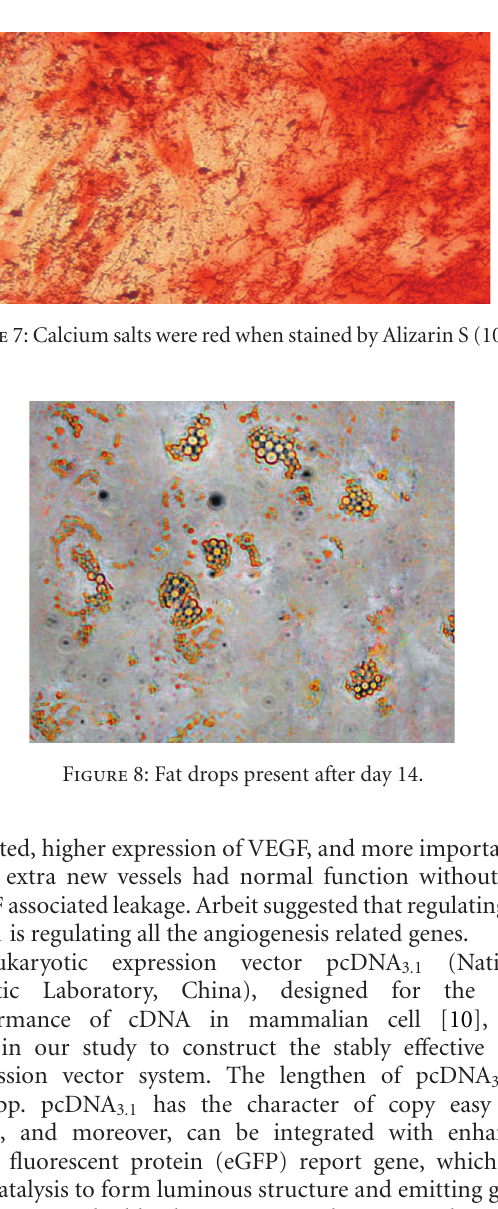
Figure 9: Fat drops were red when stained with Sudan IV and nuclei were blue when stained.